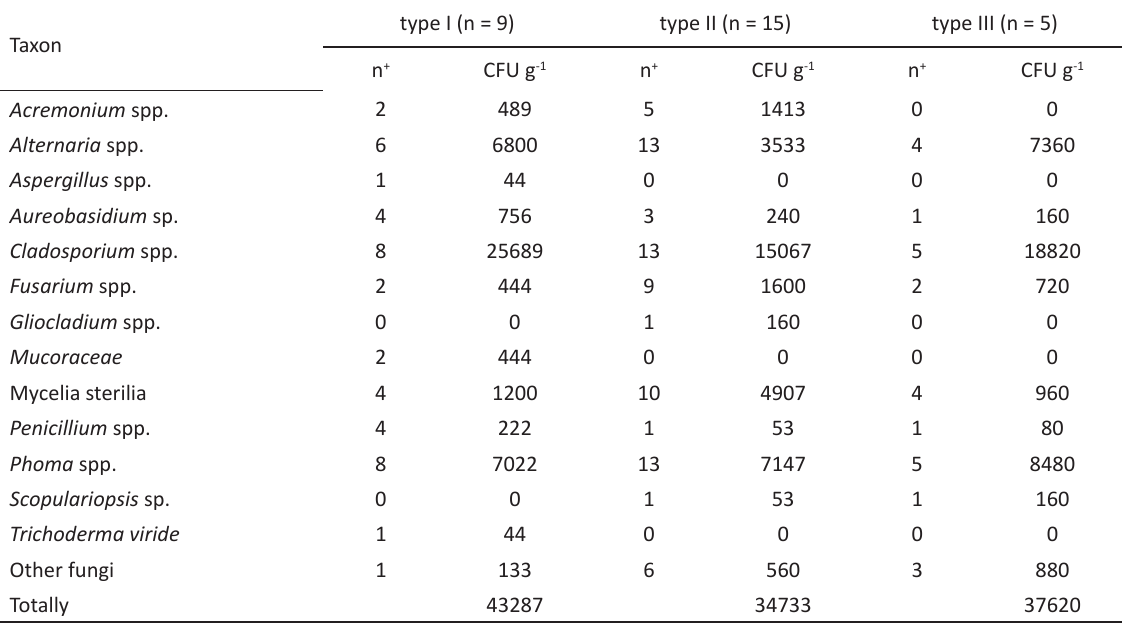
Table 1. The mycobiota of different forage types before the first mowing type I (n = 9) type II (n = 15) type III (n = 5) Taxon n + CFU g -1 n